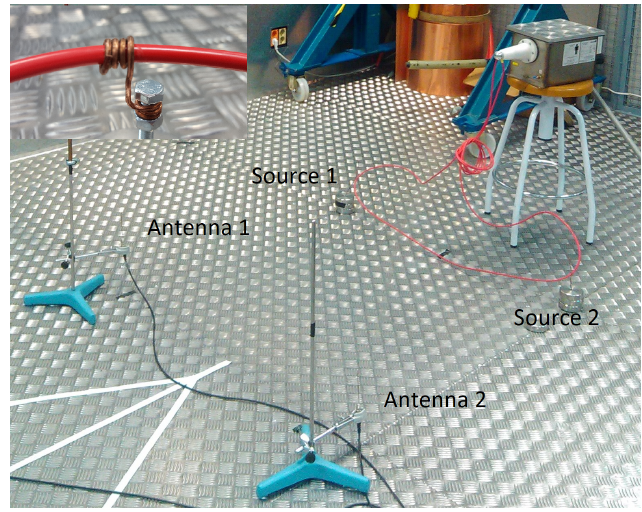
Figure 5. Setup mounted to create two sources of partial discharges with a wound copper wire around a high-voltage